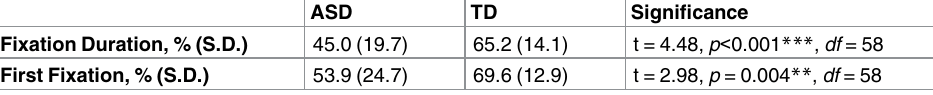
Table 2. Between-group comparisons on fixation duration and first fixation to DSI. ASD TD Significance Fixation Duration, % (S.D.) 45.0 (19.7) t = 4.48, p < 0.001 *** , df = 58 First Fixation, %